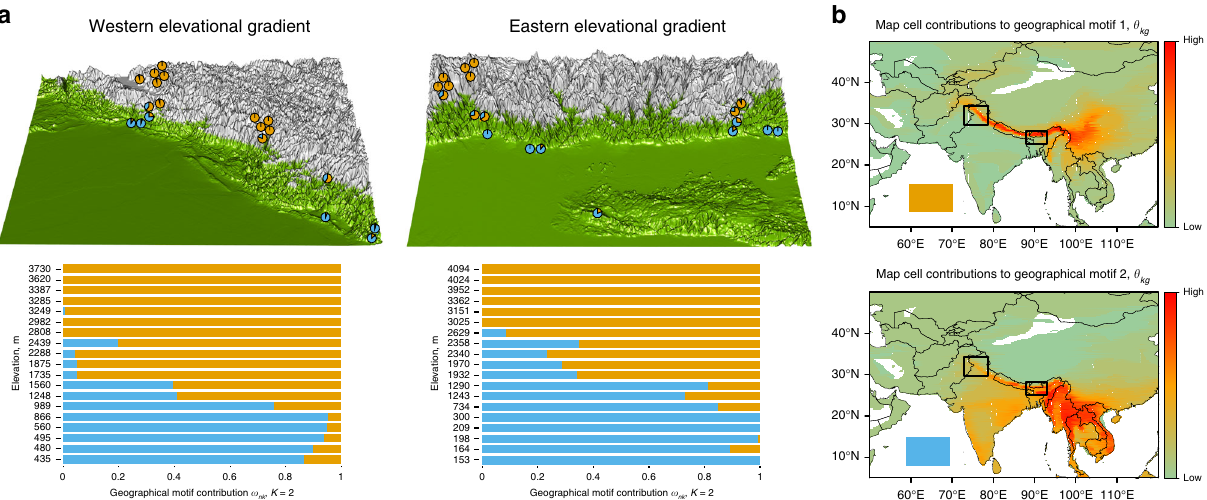
Fig. 2 Assignment of regional features to 38 local communities of Himalayan birds, K = 2 motifs. a Communities arranged by elevation within geographical regions. Colours of each bar represent the proportional contribution of the two geographical motifs to the community ’ s dispersion fi eld. These same proportions are plotted as pie charts at the locality of each community on three-dimensional maps of elevation in the west and east region; the silver shading represents the freezing line where mean minimum January temperature < 0 °C (Supplementary Fig. 5). The spatial extent of dispersion fi elds was con fi ned to the area mapped in b ( G = 201,600 map cells). b Heat map of proportional contributions of each map cell to each motif ( θ kg ), with colour intensity relative to the value of θ kg . Rectangles indicate boundaries of regions depicted in